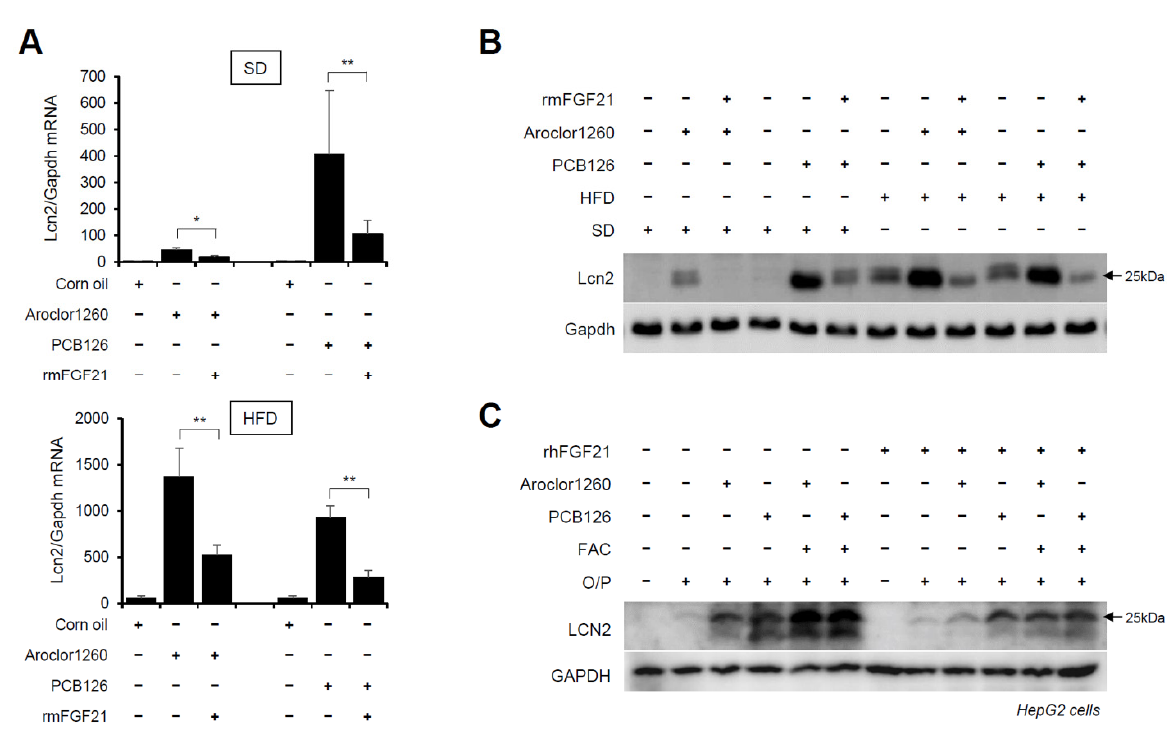
Figure 7. Recombinant FGF21 reduces PCB-induced overexpression of hepatic LCN2. Ten days after the rmFGF21 administration (1 mg/kg/day) in Aroclor1260- or PCB126-induced NAFLD/NASH mice, ( A ) real-time PCR and ( B ) western blot analysis were performed to detect mouse LCN2 in liver tissues from mice fed either a SD or HFD. The values represent the mean ± SD, n = six to eight mice per group. * p < 0.05 and ** p < 0.01. ( C ) Western blot analysis was performed to assess human LCN2 in 20 μ M Aroclor1260- or 10 μ M PCB126-treated HepG2 cells cotreated with either vehicle or rhFGF21 (50 ng/mL, 24 h).